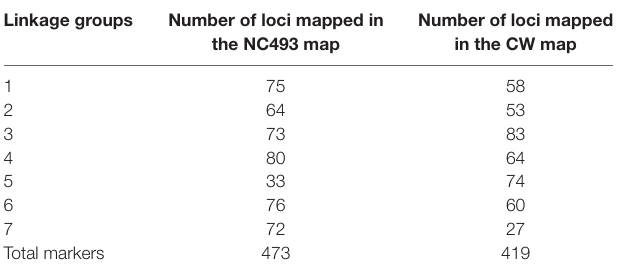
TABLE 2 | Summary of the linkage groups (LG) constructed for NC493 (Annual- Fruiting, AF) and ‘Chilliwack’ (CW, Biennial-Fruiting, BF) parents and the number of markers identified per LG.